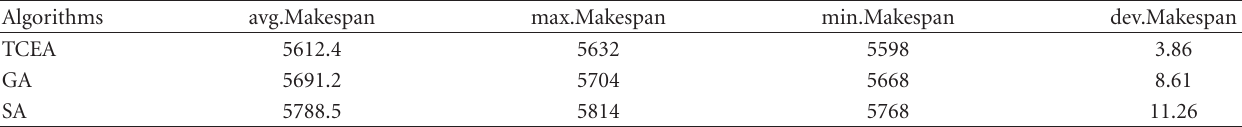
Table 4: Statistical optimization results of the 3-level MLPS with TCEA, GA and SA.